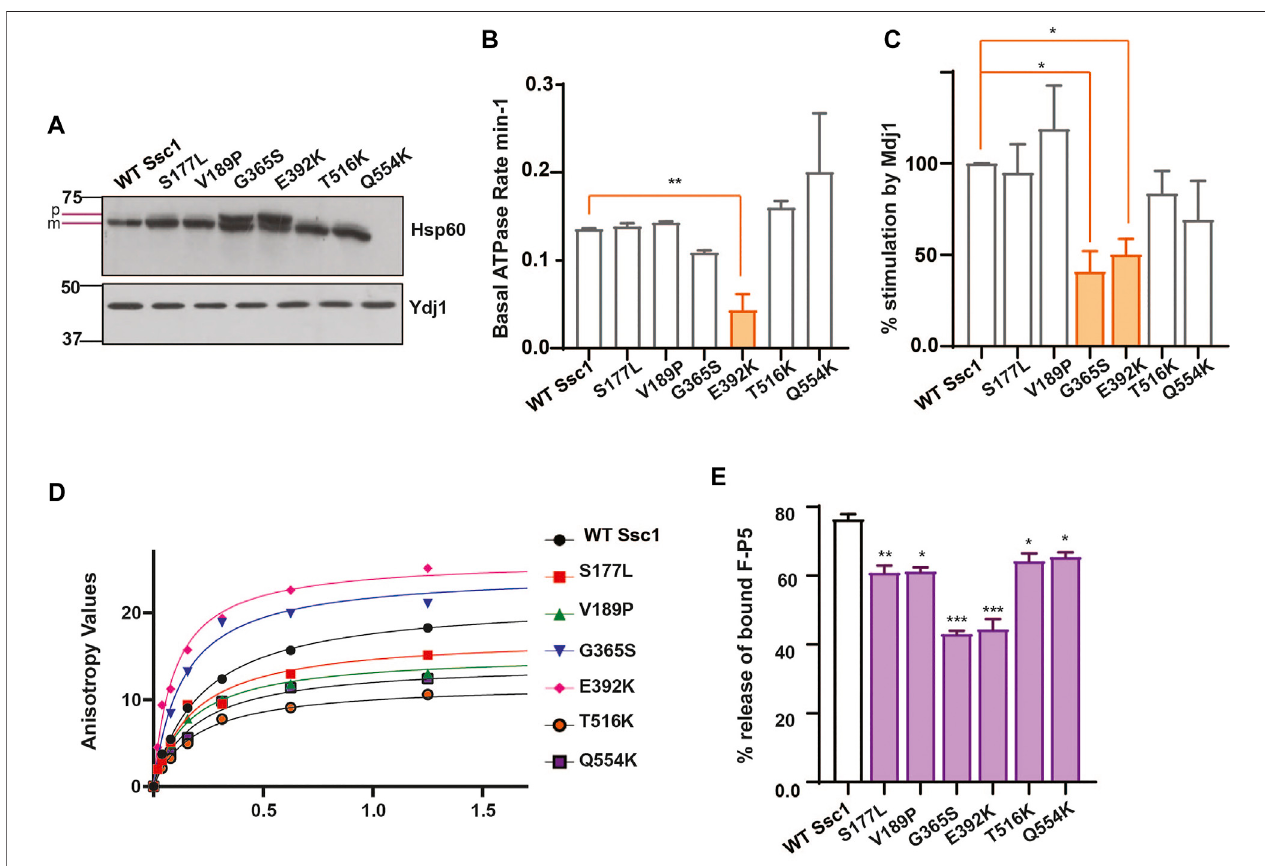
FIGURE2| Ssc1mutantsexhibitlossoffunction (A) Invivo precursoraccumulationassay.Cellsweregrownattheirrespectivepermissivetemperaturesuptoearly log phase and shifted to 37 ° C for 4 h. The cell lysates were separated by SDS-PAGE and analyzed by immunoblotting using anti-Hsp60 antibodies to determine